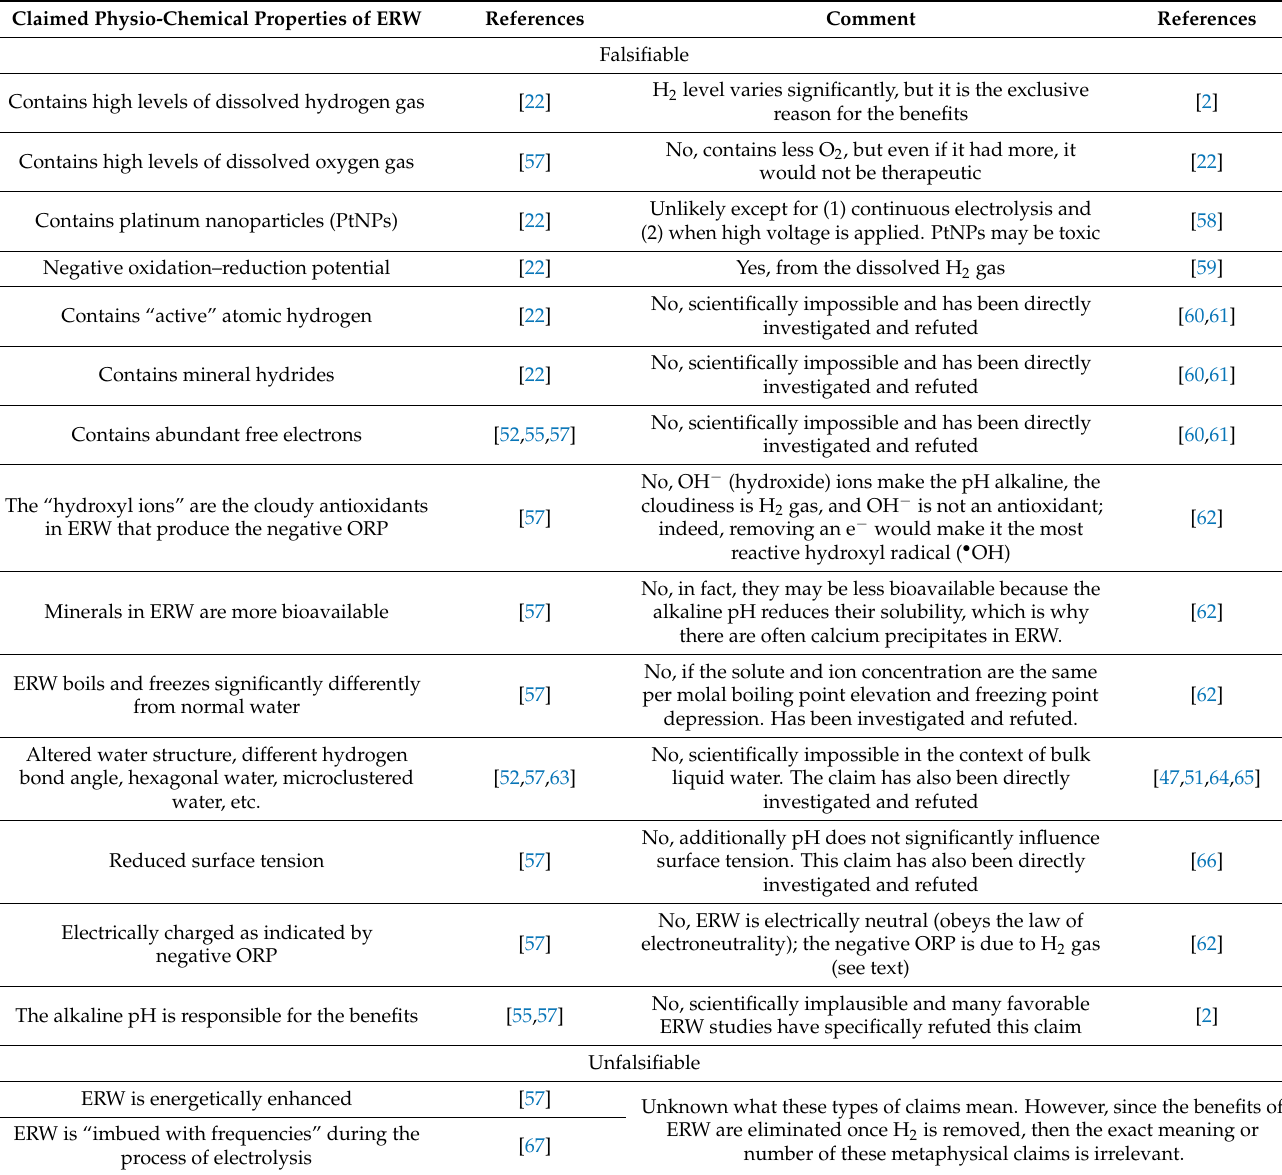
Table 1. Frequently claimed physico-chemical properties of